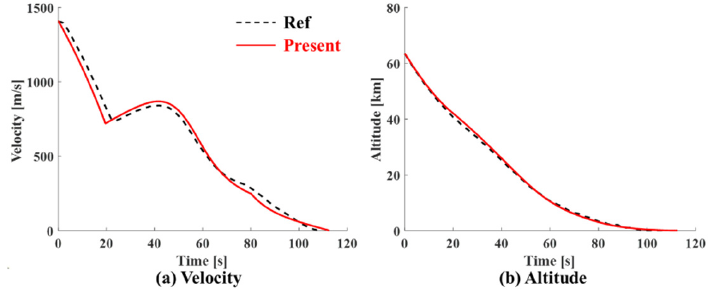
Figure 16. Validation with the actual re-entry data. ( a ) Velocity; ( b ) Altitude.